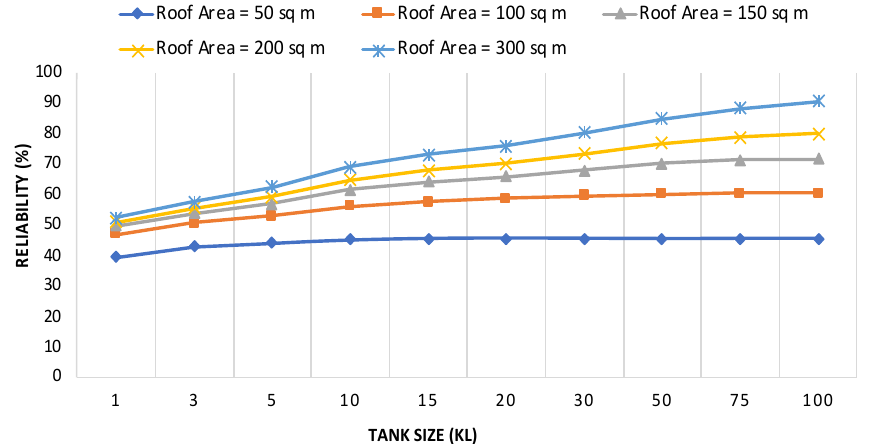
Figure 4. Reliability–roof area–tank size relationships for Sydney (combined use).